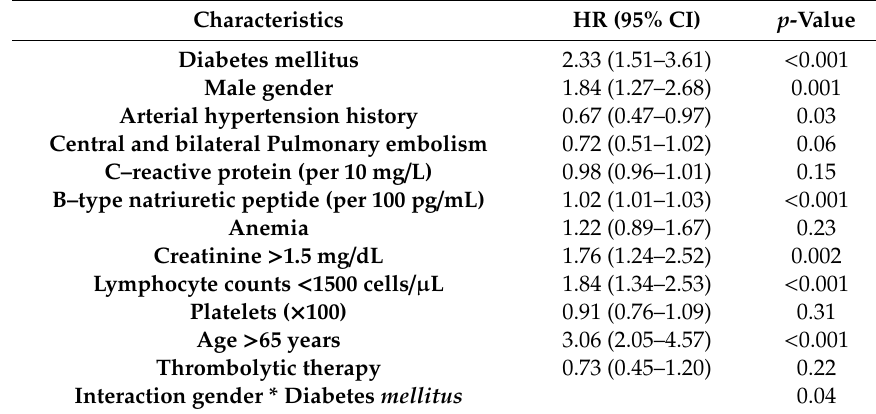
Table 2. Survival predictors in acute PE: Cox-multivariate model.